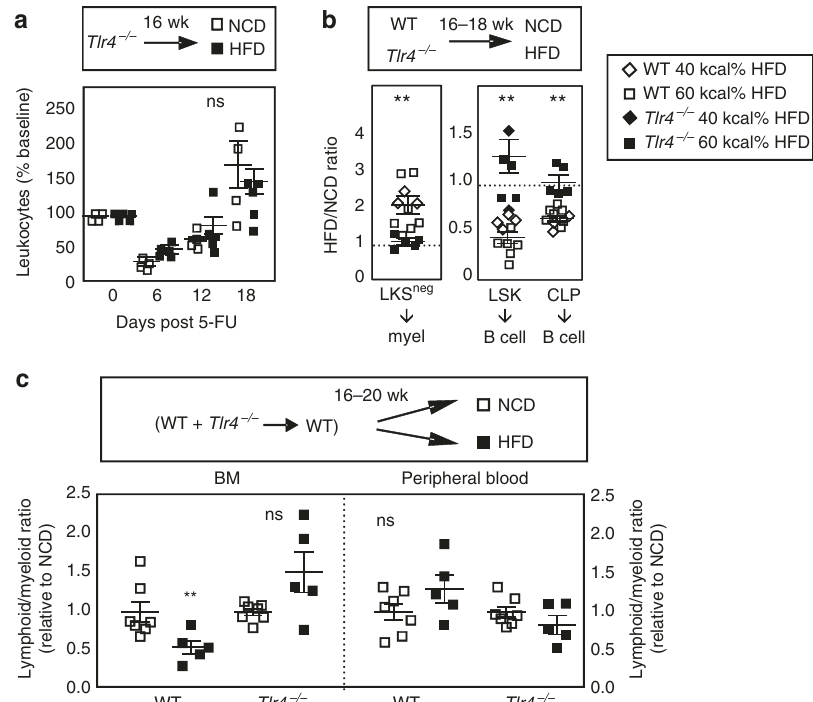
Fig. 3 Myeloid>lymphoid BM bias requires TLR4. a Mice fed the 60 kcal% (square symbols) high-fat diet or matched control diet for 16 weeks were exposed to the chemotherapy drug 5-FU and peripheral blood leukocyte rebound tracked at the indicated time points. Data are pooled from two independent experiments of NCD/HFD mice analyzed side-by-side. b WT or Tlr4 − / − mice were fed 40 kcal% (diamond symbols) or 60 kcal% (square symbols) high-fat or matched control diet for 16 – 18 weeks after which sorted LKS neg and CLP outgrowth was assessed in liquid assays as in Fig. 2. Data are pooled from four independent experiments of NCD/HFD mice examined in parallel. c WT (CD45.1) or Tlr4 − / − (CD45.2) BM was mixed and co-transferred to CD45.1/2 recipients, after which mice were rested for 1 week and then fed 60 kcal% (square symbols) high-fat or control diet for 16 – 20 weeks. (B220 + CD3)/Gr-1 is shown as lymphoid/myeloid ratio. Data are pooled from two independent experiments performed with different BM donors and 2 – 3 recipients/group. Each symbol is an individual animal. Data are analyzed by Student ’ s t- test. Error bars represent s.e.m. ** p < 0.05; ns, not signi fi